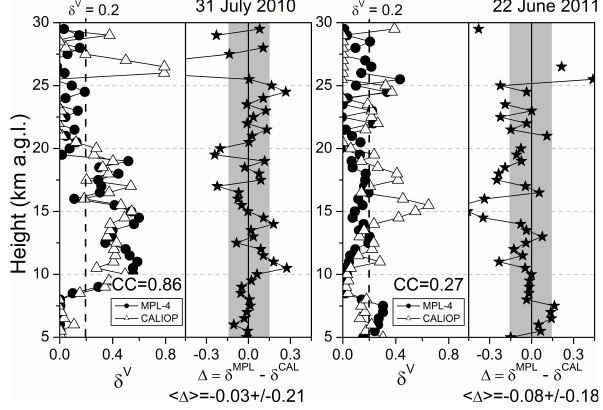
Fig. 10. The same as for Fig. 8, but for the CALIPSO D3 dis- tance range (45–55km). PSC events correspond to those cases with a high/moderate and low CC values as observed, respectively, on 22 August 2011 (left) and 12 July 2010 (right).